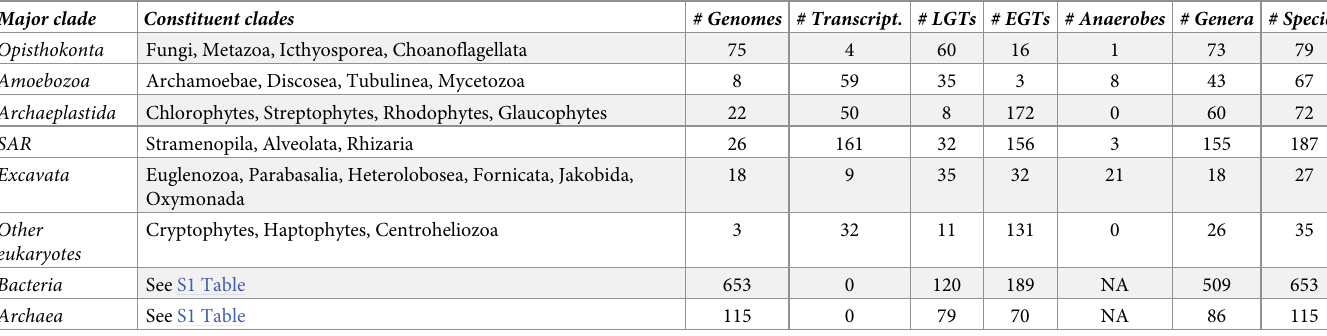
Table 1. The taxonomic breadth of data used in the